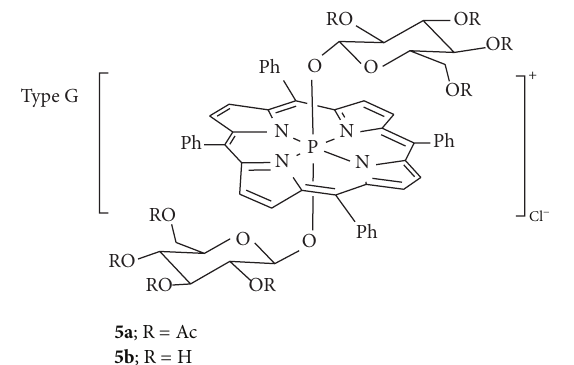
Scheme 5: Type G: di(glycosyl)(tetraphenylporpyrinato)-phospho-